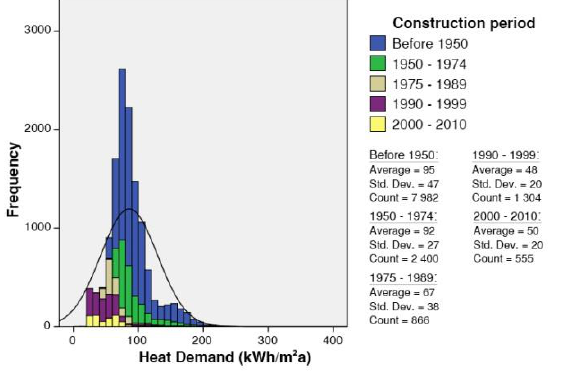
Figure 6: Distribution of the heat energy demand per construction considering the scenario B “all refurbished”.